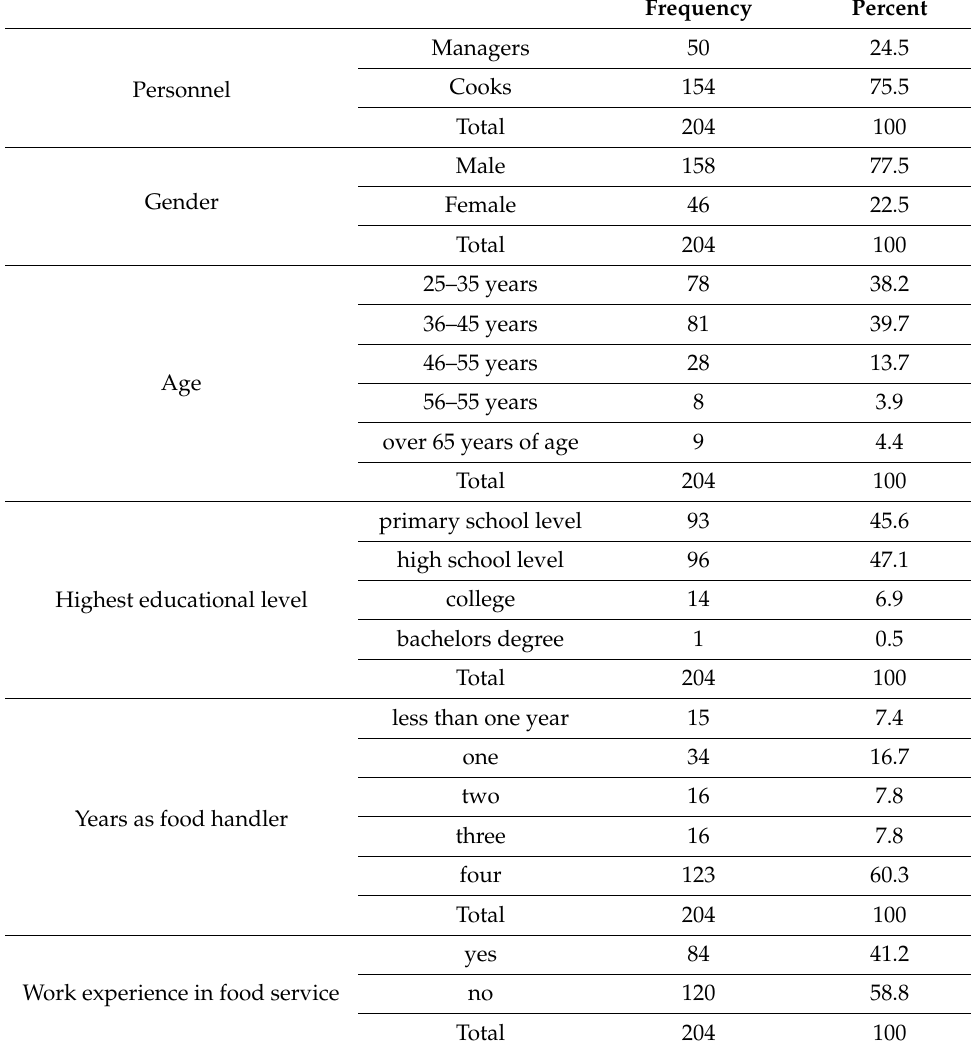
Table 1. Socio-demographic characteristics of food handlers in Kenyan secondary school